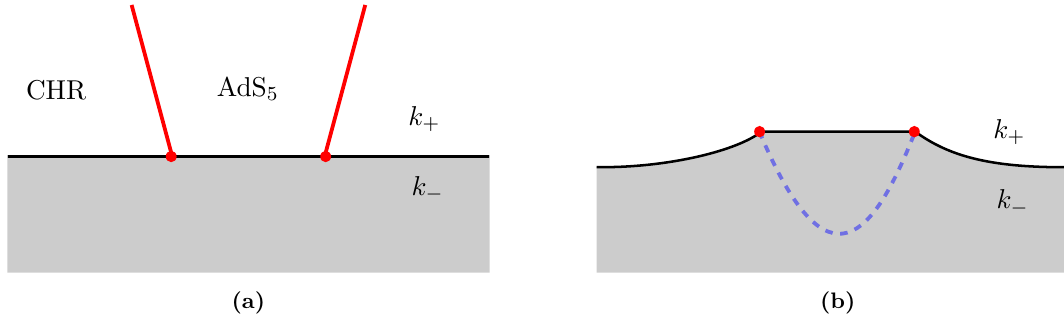
Figure 1. A cross-section of a thin, rigid shell of four dimensional matter on the dark bubble seen (a) from outside, and (b) from inside. The two figures are given in two different gauges as explained in the text. The gray region indicates the inside of the dark